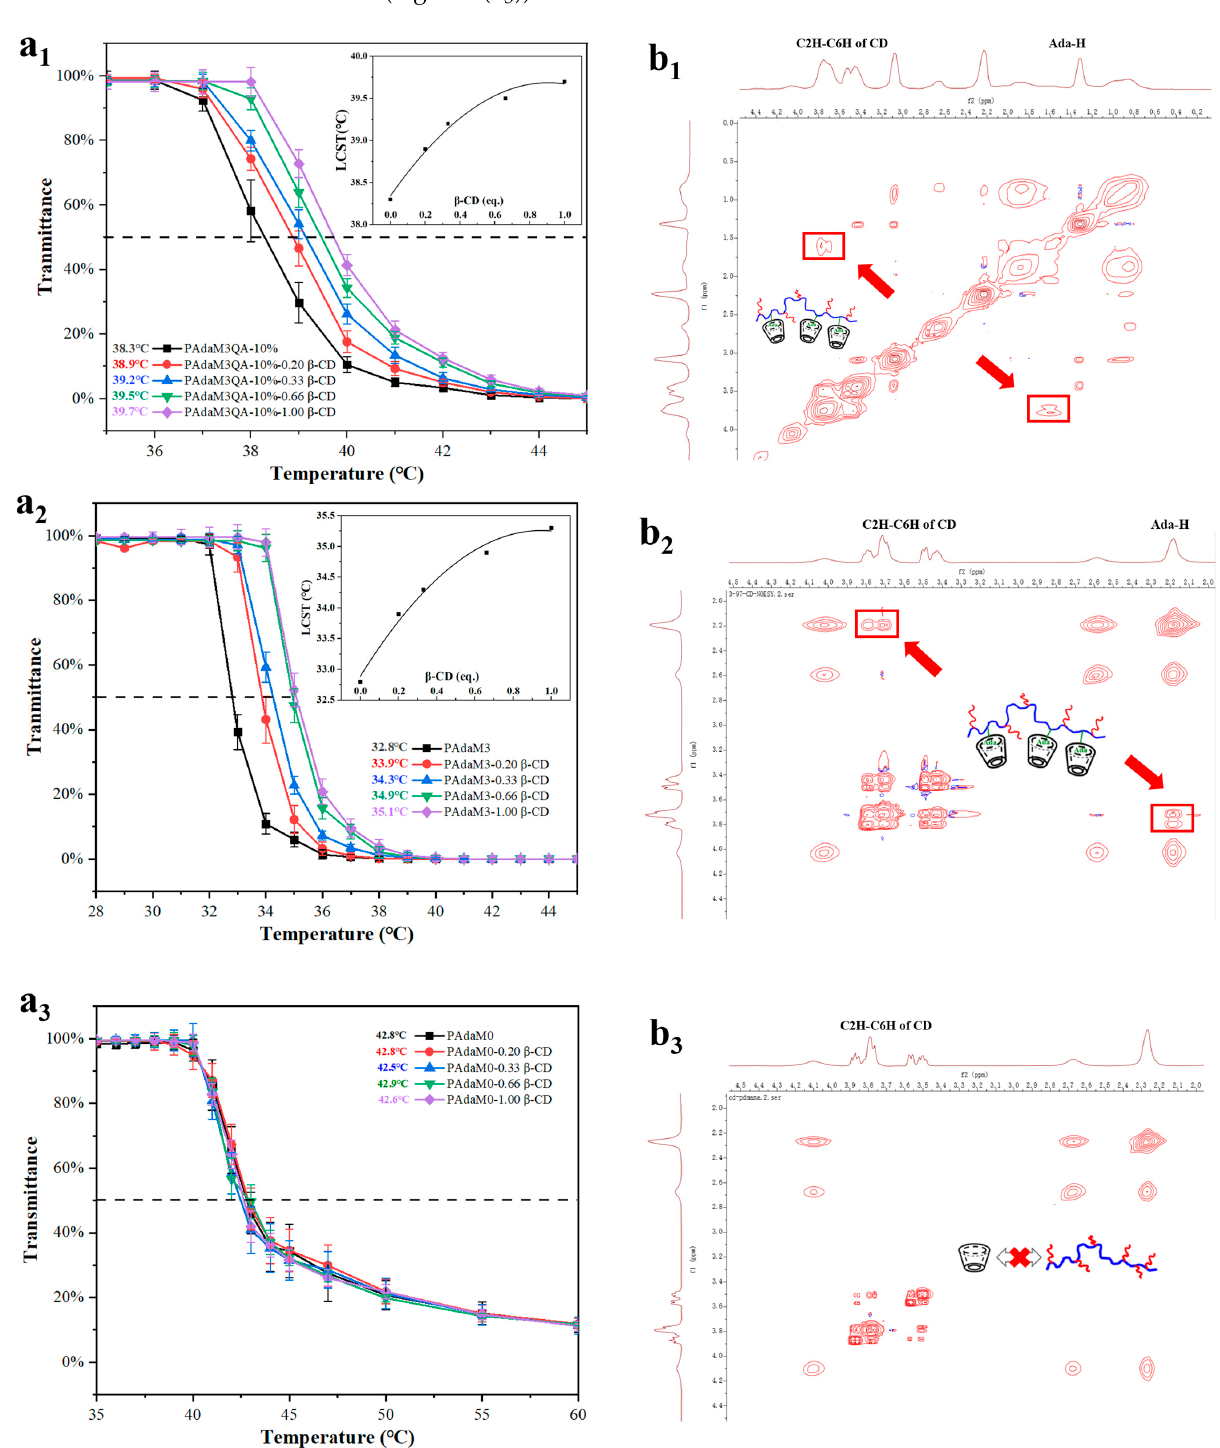
Figure 8. The effect of β -CD on the LCST of ( a 1 ) PAdaM3QA − 10%, ( a 2 ) PadaM3, and ( a 3 ) PAdaM0 solutions; partial 2D NMR NOESY spectra of the mixture of β -CD and ( b 1 ) PAdaM3QA − 10%, ( b 2 ) PAdaM3, and ( b 3 ) PAdaM0 in water at 30 °C.